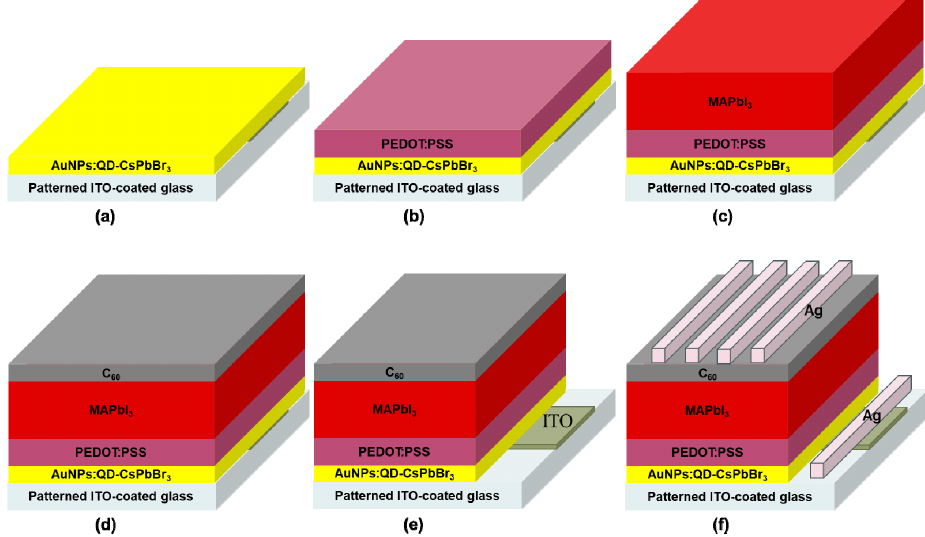
Figure 1. Plasmonic perovskite solar cell process steps. Preparation of ( a ) a plasmonic gold nanoparticle:CsPbBr 3 hybrid perovskite quantum dot (AuNPs:QDs-CsPbBr 3 ) light-harvesting layer on patterned indium tin oxide (ITO)-coated glass, ( b ) PEDOT:PSS hole injection layer, ( c ) perovskite MAPbI 3 active layer and ( d ) C 60 electron transport layer; ( e ) Scrapping the film and defining the study area; ( f ) Ag electrode deposition and the plasmonic perovskite solar cell device.